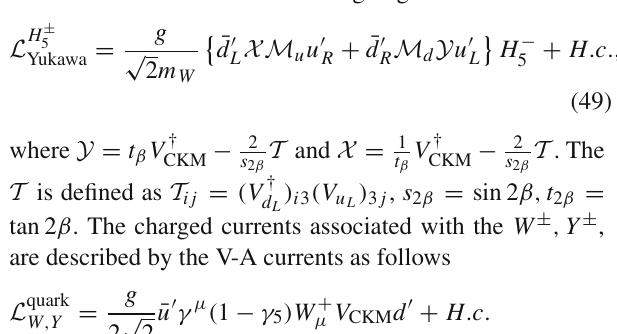
Fig. 3 The left panel draws the Br ( B s → μ + μ − ) : red curve presents the prediction values of the 3-3-1-1 model, gray line represents the cen- tral values of the SM prediction. The blue and green lines represent the experimental upper and lower bounds. The right panel predicts the NP